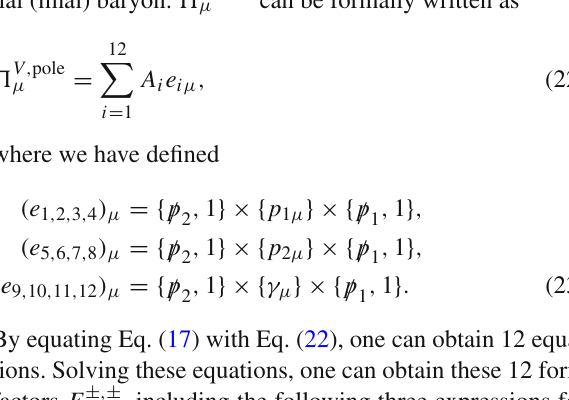
where s 0 is the continuum threshold parameter for the 1 ( 2 )